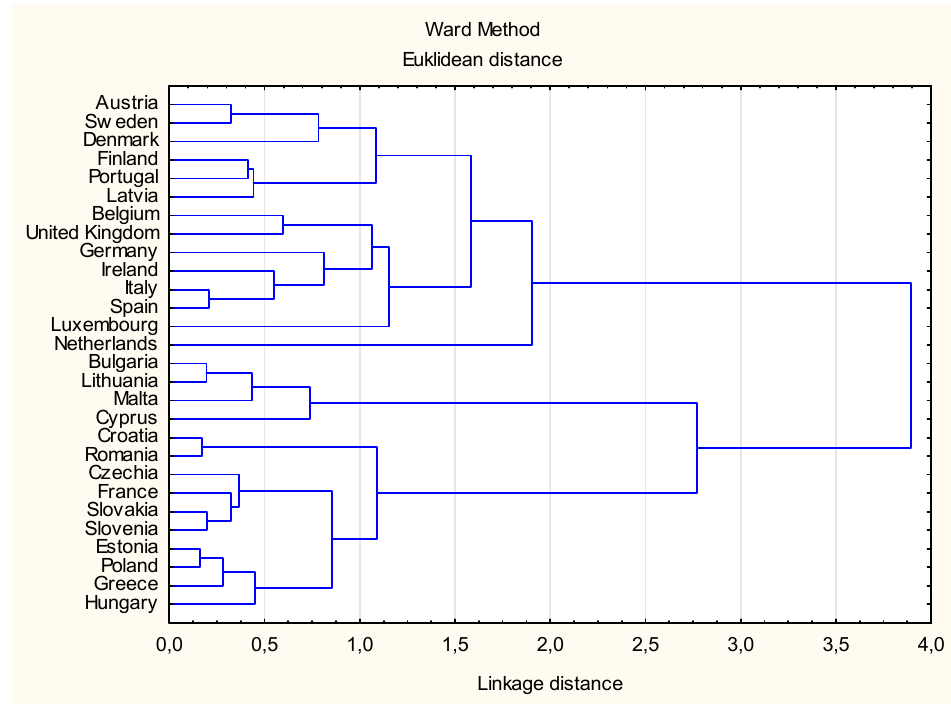
Figure 4. Agglomeration analysis results for EU28 countries. Source: authors’ calculations.